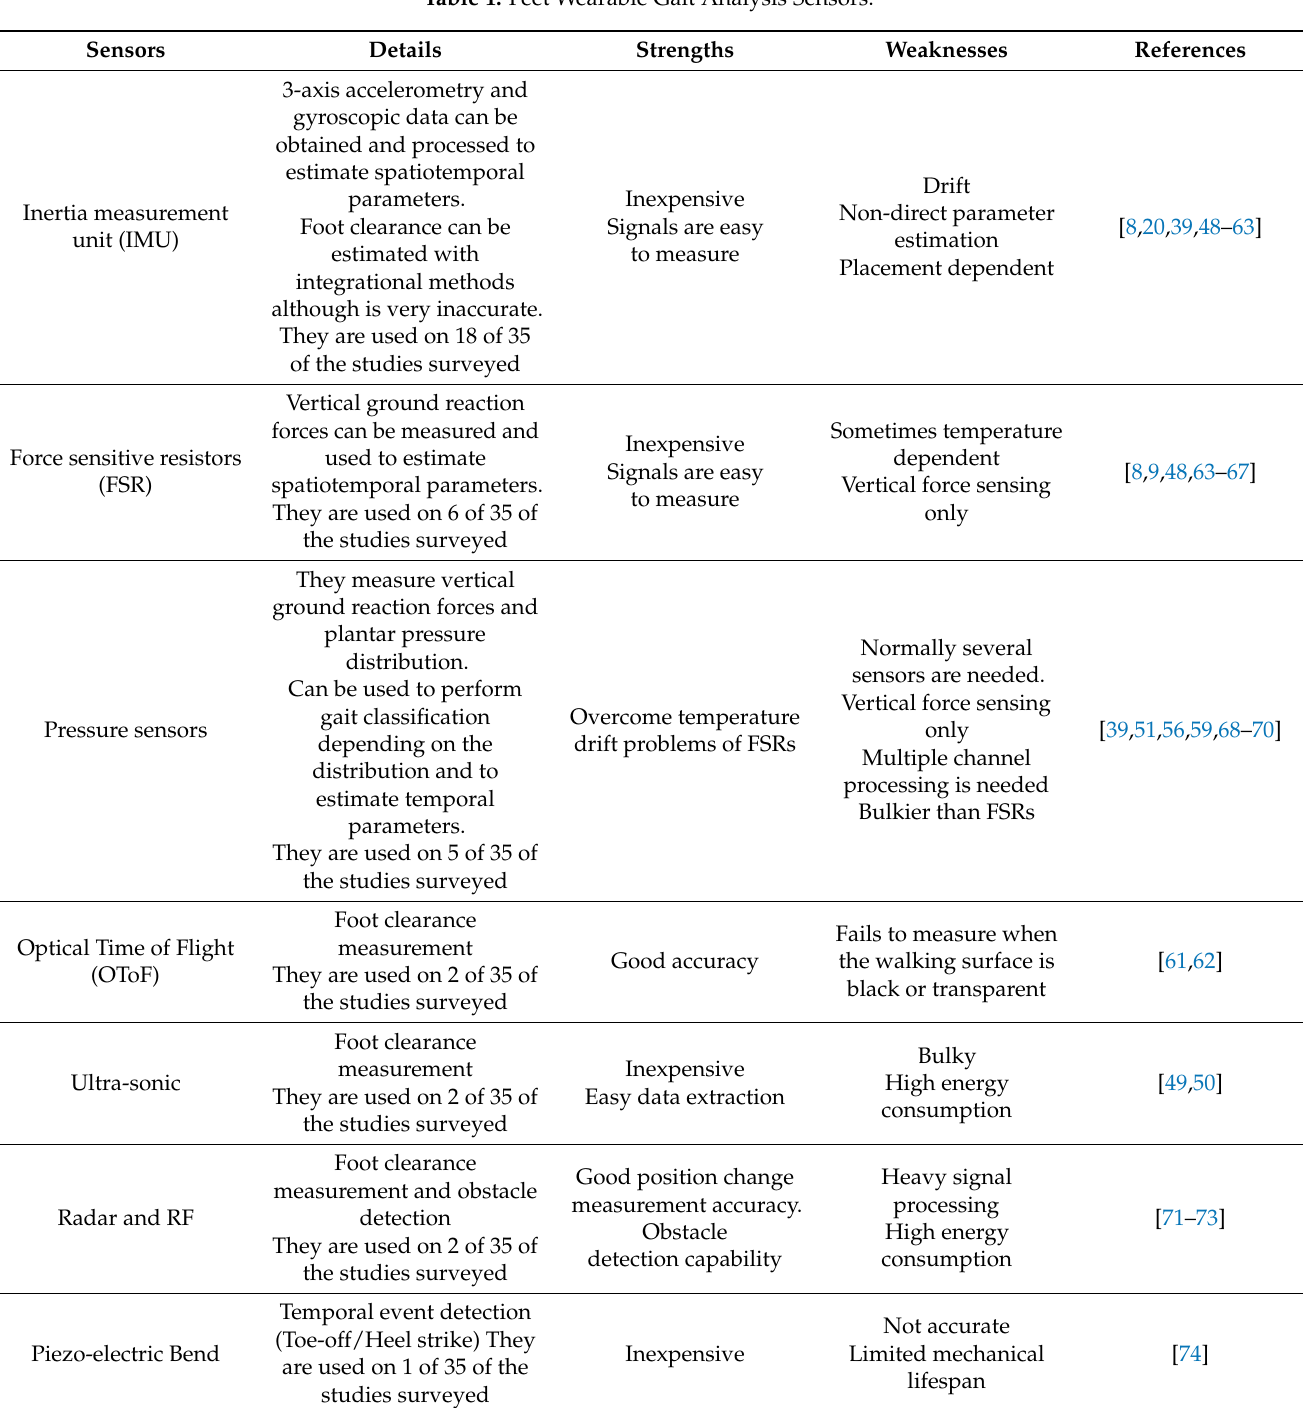
Table 1. Feet Wearable Gait Analysis